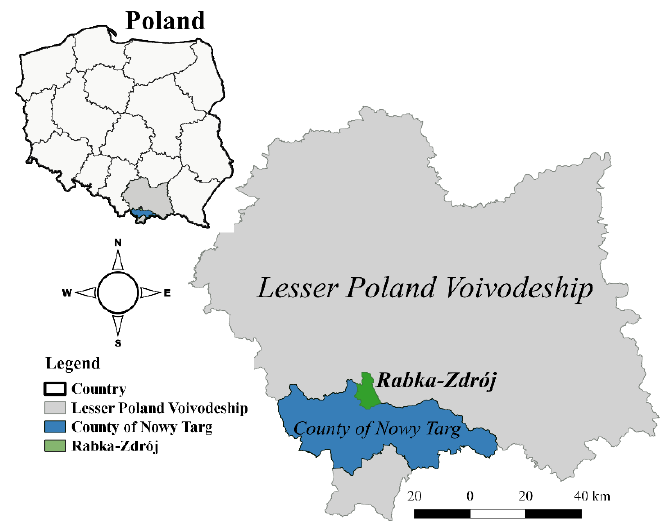
Figure 1. Location of the study area.